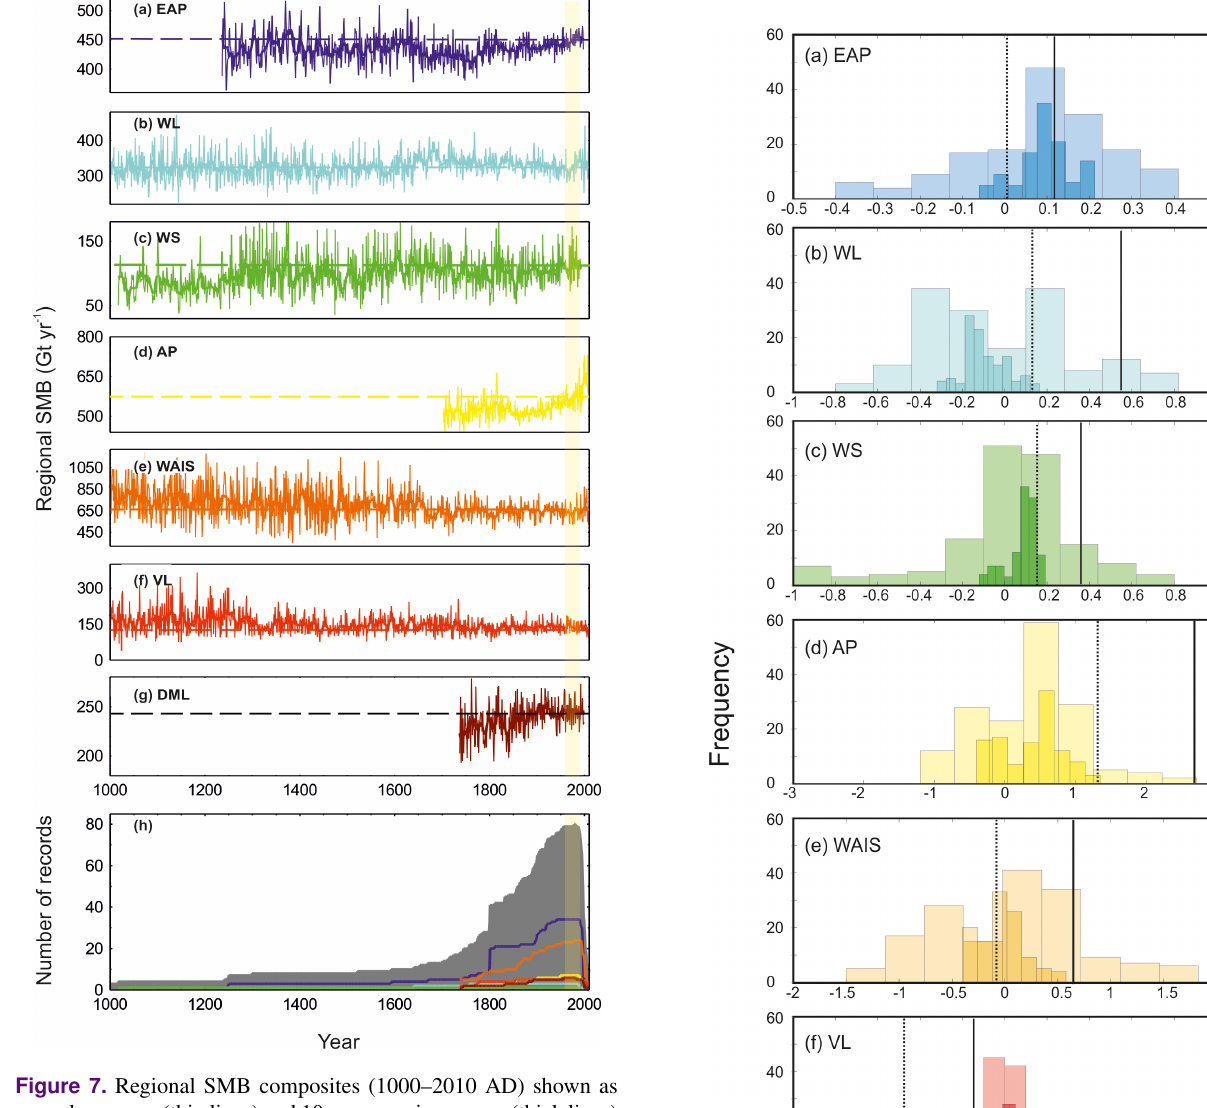
Figure 7. Regional SMB composites (1000–2010 AD) shown as annual averages (thin lines) and 10-year running means (thick lines) for (a–g) the East Antarctic Plateau (EAP, dark blue); Wilkes Land coast (WL, cyan), Weddell Sea coast (WS, green), Antarctic Penin- sula (AP, yellow), West Antarctic Ice Sheet (WAIS, orange), Vic- toria Land (VL, red), and Dronning Maud Land (DML, brown). Panel (h) represents the total number of records (solid grey) and the number of records by region.